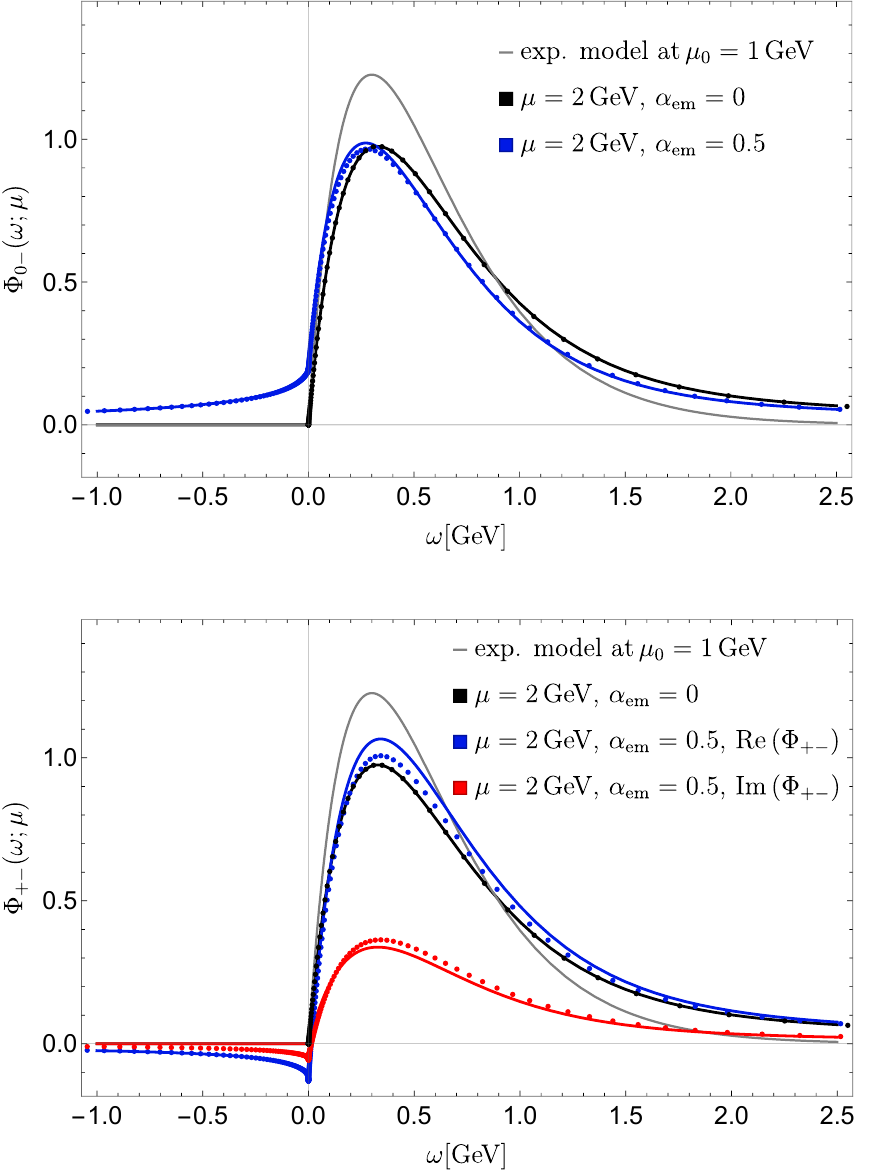
Figure 3 . Scale evolution of the soft functions Φ 0 − ( ω ; µ ) (upper panel) and Φ + − ( ω ; µ ) (lower panel) in QCD versus QCD × QED. The exponential model (4.2) (gray curve) with ω 0 = 0 . 3 GeV is evolved from the hadronic scale µ 0 = 1 GeV to a typical hard-collinear scale µ = 2 GeV. The black line shows the analytic result (4.3) for the evolved function in the absence of QED effects. The blue (red) curve displays the first-order O ( α em ) solution (4.4), (4.5) for the real (imaginary) part of Φ + − ( ω ; µ ) for α em = 0 . 5 . The dots represent the results from the numerical solution obtained by discretization of the unapproximated evolution equation. We recall that Φ 0 − ( ω ; µ ) has zero imaginary part and do not display the corresponding red